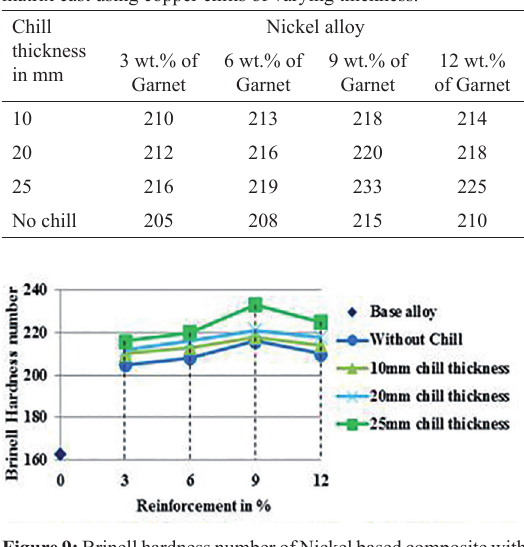
Figure 9: Brinell hardness number of Nickel based composite with varying chill thickness and % Garnet